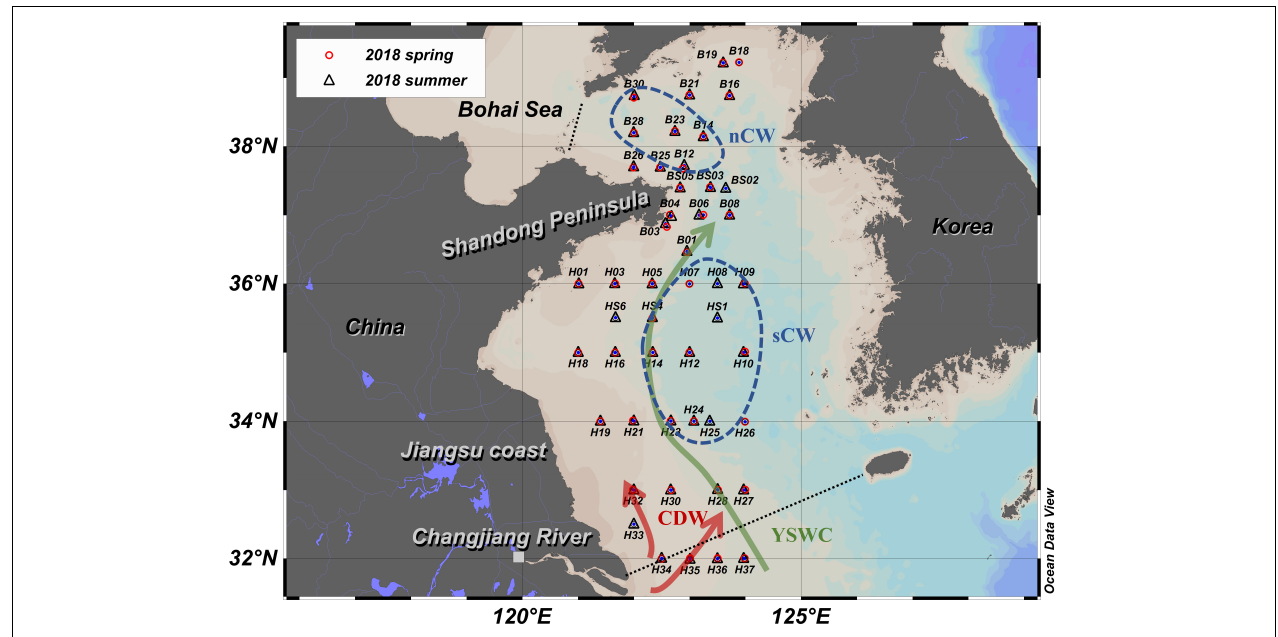
FIGURE 1 | Sampling stations of spring and summer cruises are marked by red circles and black triangles, respectively. Note that most of the stations were sampled on both expeditions. The southern and northeastern boundary of the Yellow Sea is marked by the black dashed line. Yellow Sea Warm Current (YSWC) and Changjiang Diluted Water (CDW) are important external waters in spring and summer, respectively. These currents are drawn according to their general positions and our data of 2018. Sampling stations clustering in the north Cold Water mass (nCW) and south Cold Water (sCW) stations are marked by blue dashed lines, nCW and sCW are water masses defined in this study, they both are part of the Yellow Sea Cold Water Mass (YSCWM). (base map sourced by Ocean Data View, Schlitzer, Reiner, Ocean Data View, https://odv.awi.de, 2021).